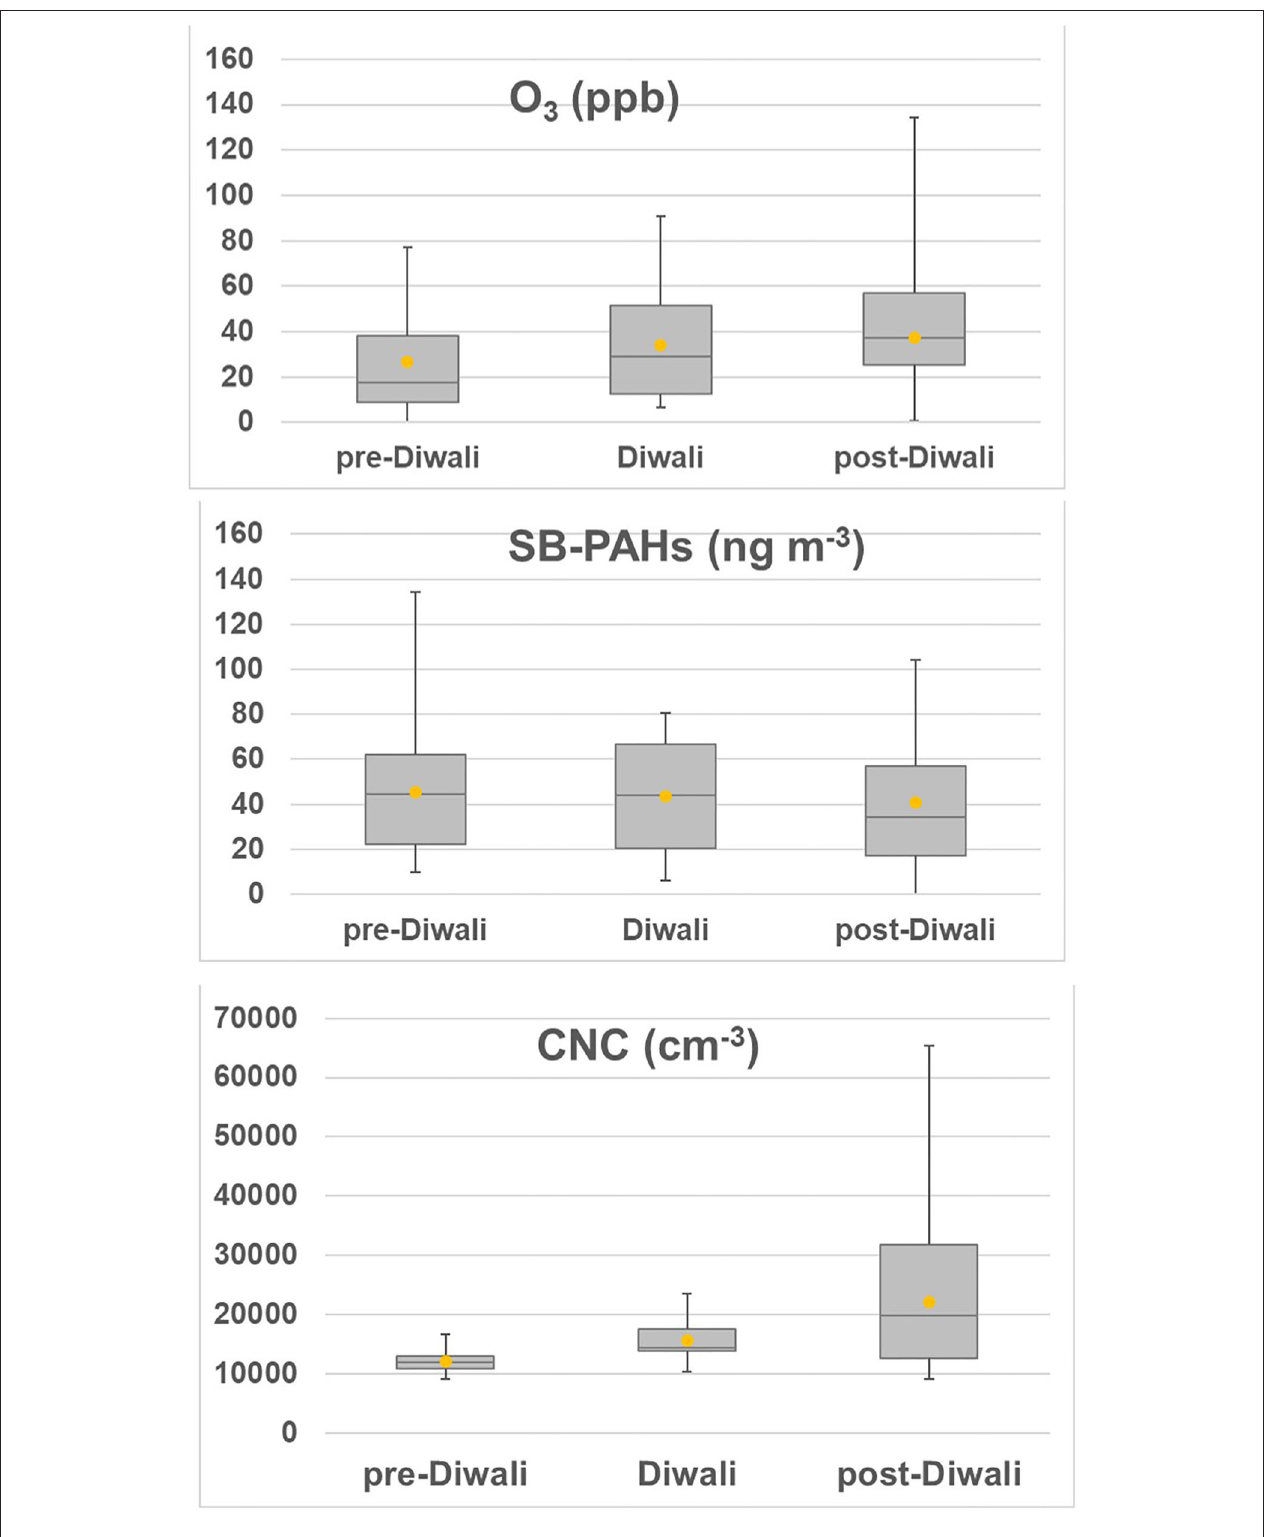
FIGURE 5 | Boxplot showing a summary of overall variability [minimum, maximum, median (horizontal line), and mean (filled circle)] of O 3 , SB-PAHs, and CNC during pre-Diwali, Diwali, and post-Diwali periods.